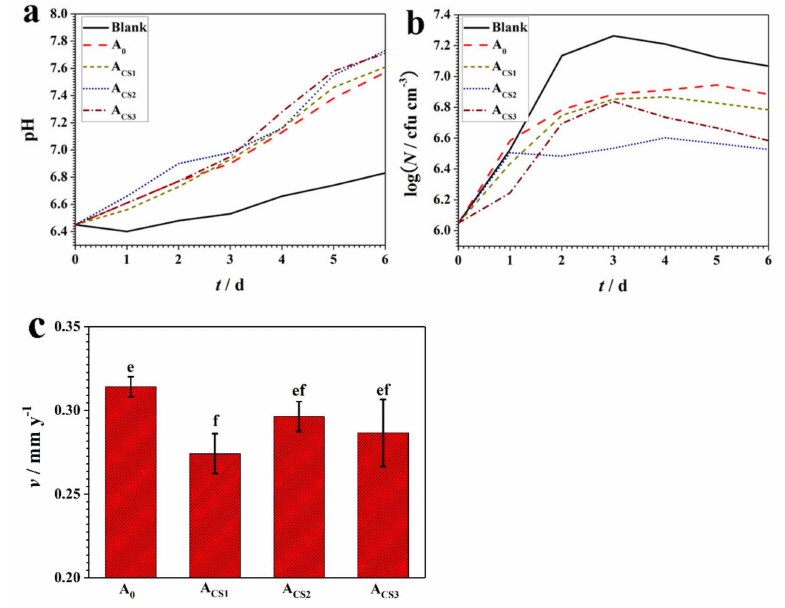
Figure 6. ( a ) The pH value and ( b ) the bacterial concentration variations of the SRB medium with the coatings exposed for six days; ( c ) the corrosion rates of the coatings after six days of exposure in the SRB medium, means with letters e and f denoting significant di ff erences ( p <